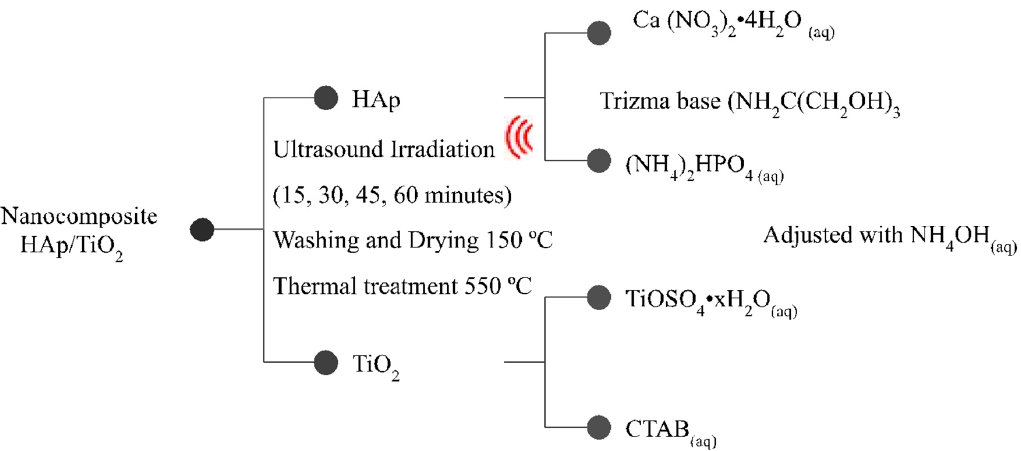
Figure 1. Diagram of the synthesis of HAp, TiO 2 , and HT nanocomposite.